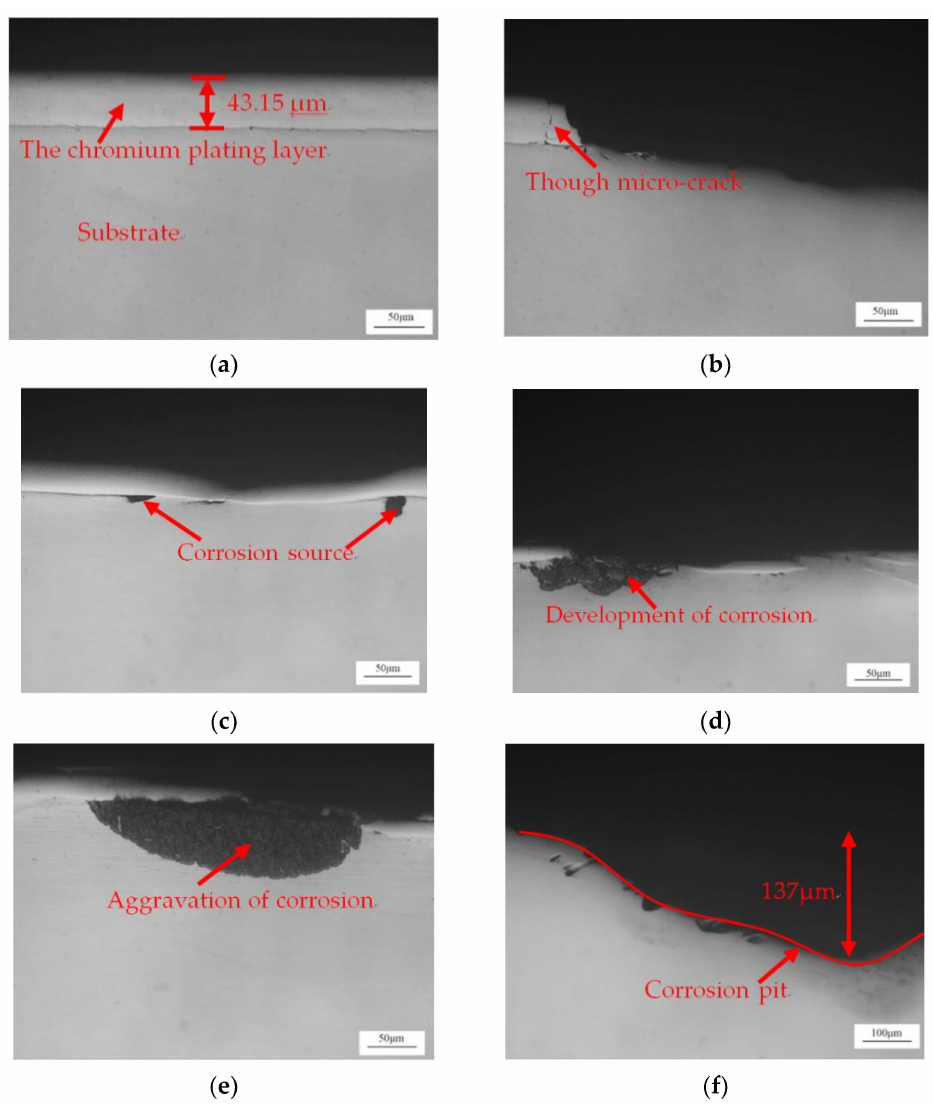
Figure 9. OM observation on the bonding state of the chromium plating layer and substrate: ( a ) intact part; ( b ) though micro-crack; ( c ) corrosion source; ( d ) development of corrosion; ( e ) aggravation of corrosion; and ( f ) the cross-section of corrosion